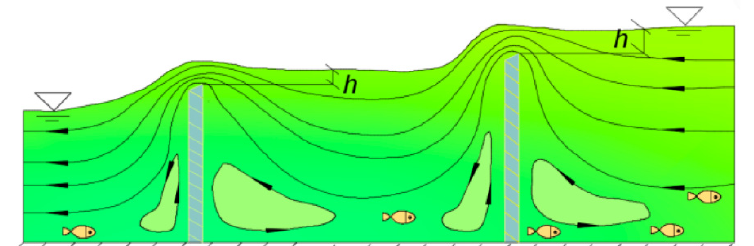
Figure 1. Sketch of conventional multistage weir outflow. The flow velocity close to the weirs decreases while the upstream water level increases. Supplying a continuous free surface is one of the advantages of multistage weirs.